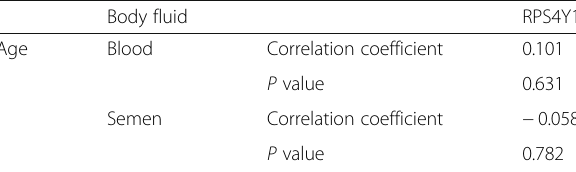
Table 6 Comparison between RPS4Y1 mean values in male blood and semen Gene